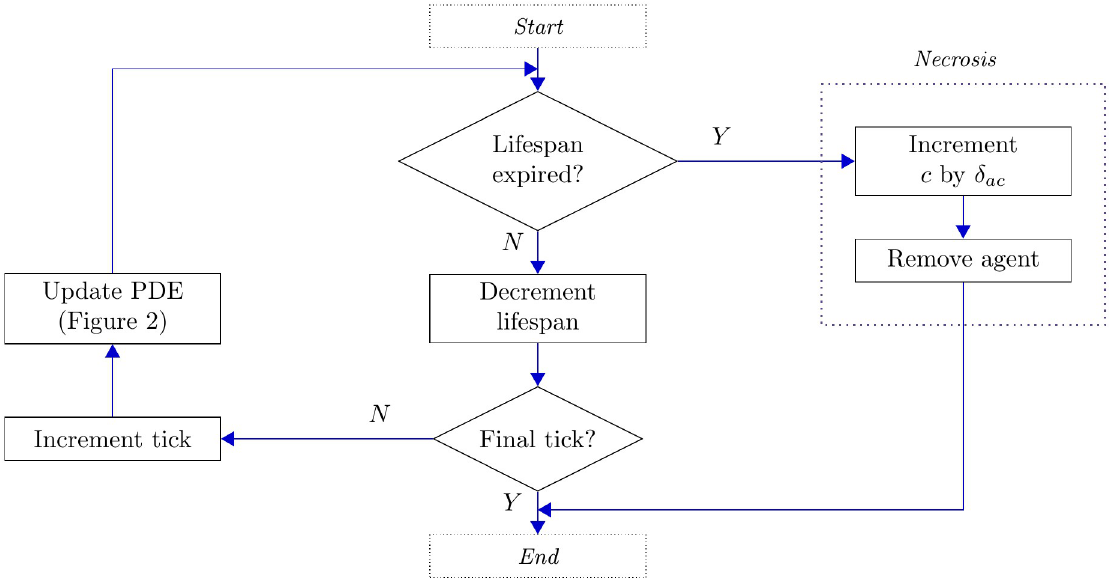
Fig 5. Flow chart illustrating the actions of each agent of the apoptotic